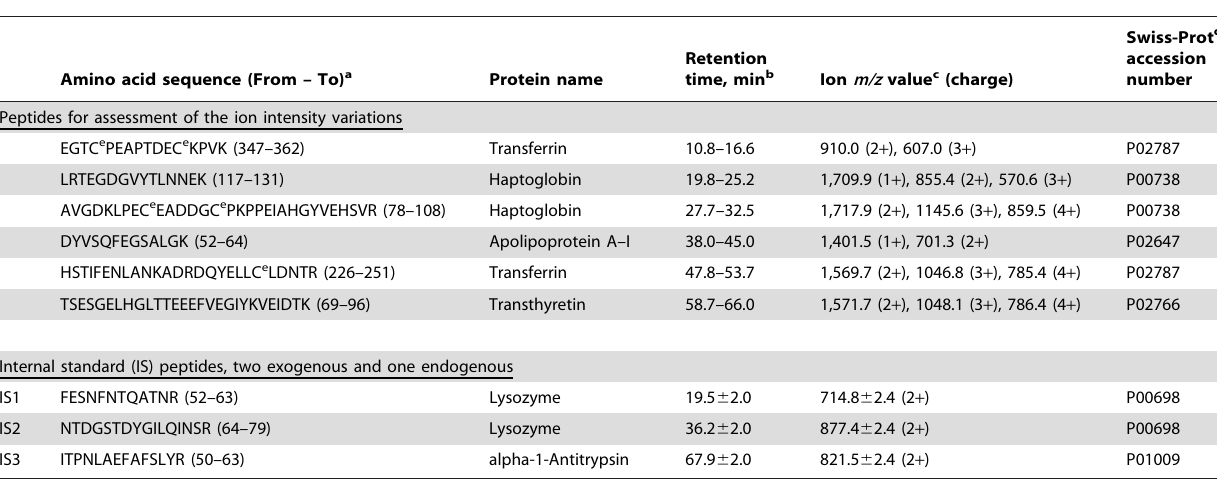
Table 3. Peptides used as internal standards and for assessment of the ion intensity variations across the LC-MS/MS measurement